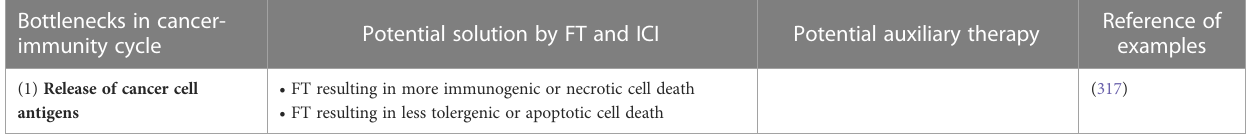
TABLE 12 Potential solutions to the bottlenecks in the major steps that arrest the self-propagating cancer-immunity cycle by combinatory focal therapy (FT) and immune checkpoint inhibitor (ICI). Bottlenecks in cancer- Potential solution by FT and ICI Potential auxiliary therapy immunity cycle